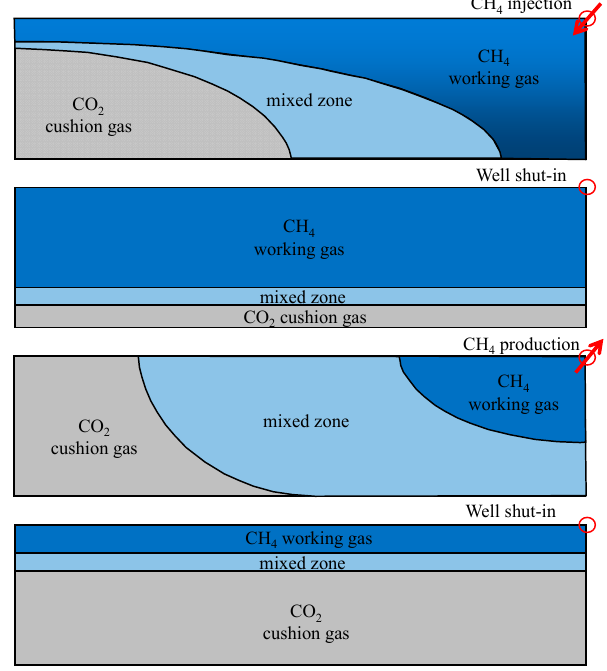
Figure 1. The schematic diagram of natural gas storage reservoir with CO 2 cushion gas.